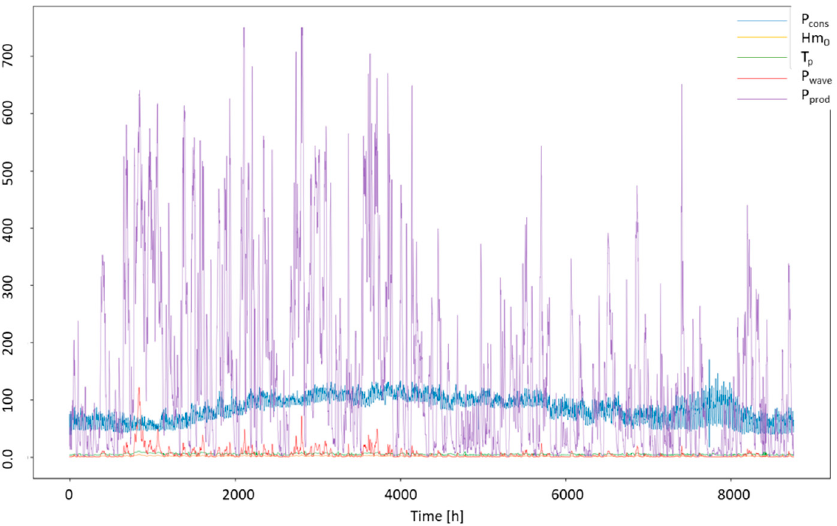
Figure 10. Power consumption, Power production and Power per meter of wave crest (Pcons, Pprod and Pwave) in kW for 2016, 2 Weptos configuration.